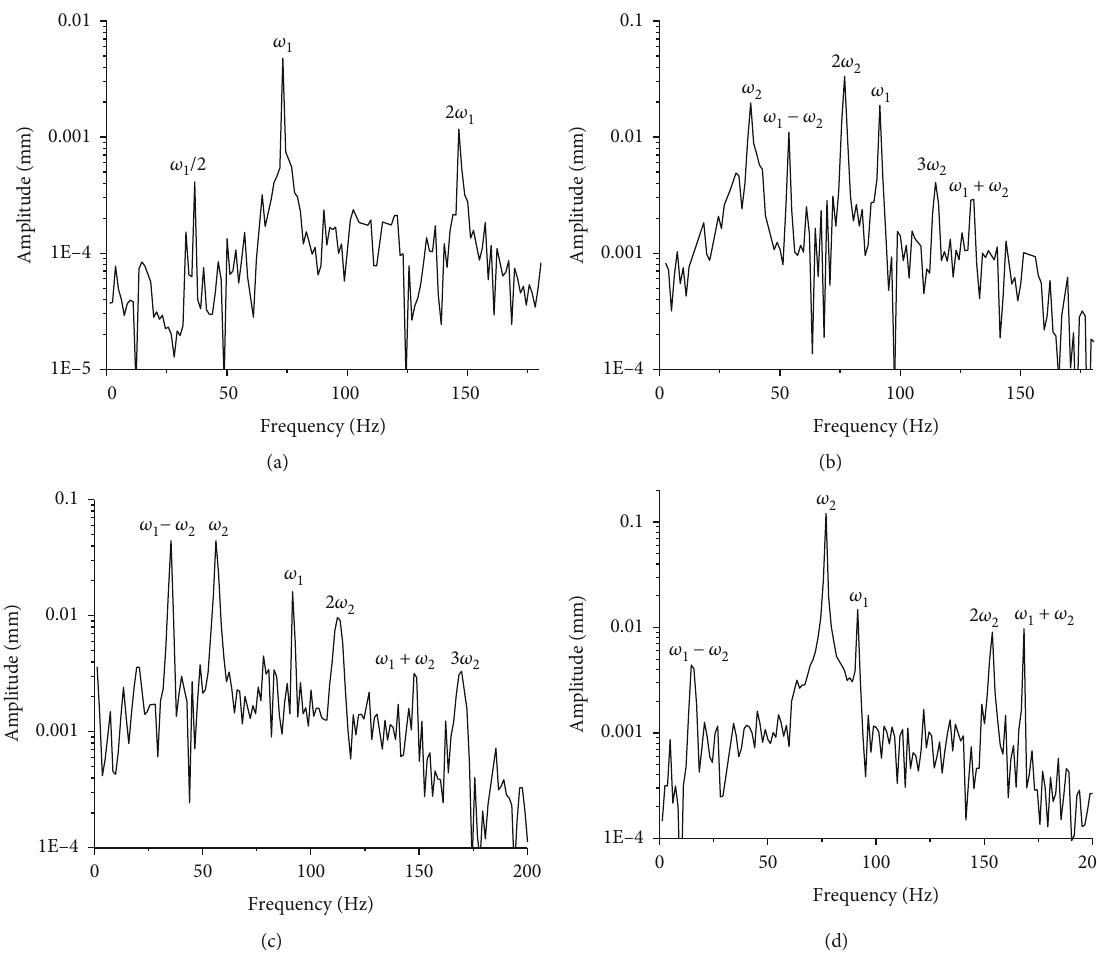
Figure 12: Test results: the 2D spectrum map at di ff erent times: (a) 70s; (b) 240 s; (c) 280s; (d)